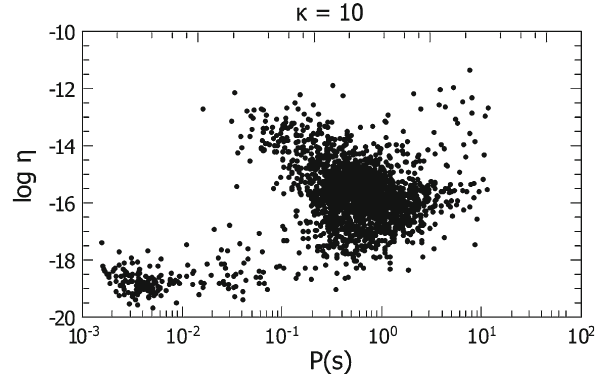
Fig. 6 Histogram of the amplitude of GWs for all pulsars with known P , ˙